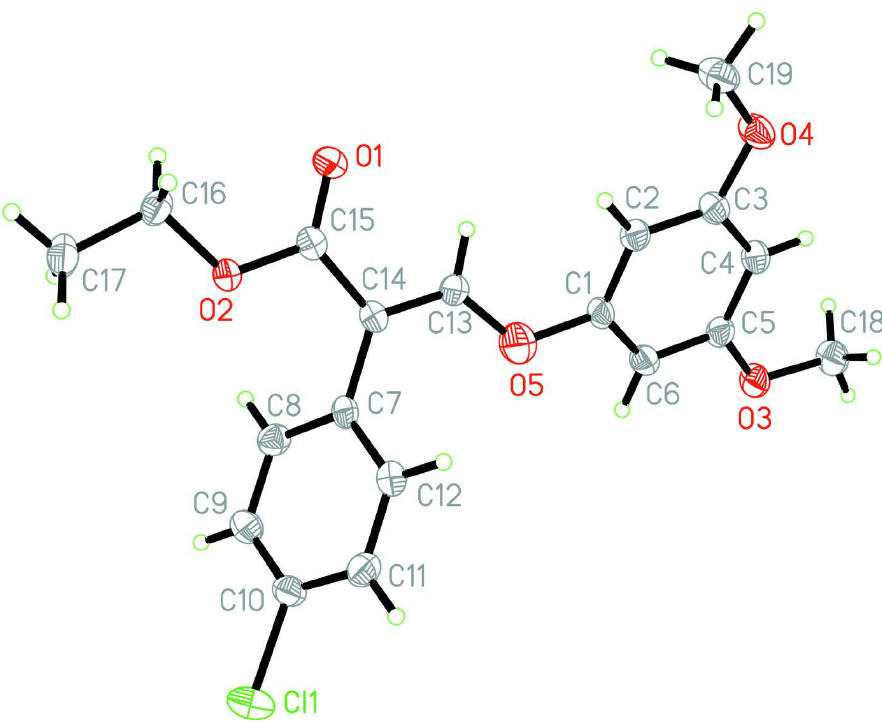
Figure 1 The molecular structure of compound (I), showing the atom-numbering scheme and displacement ellipsoids drawn at the 30% probabilty